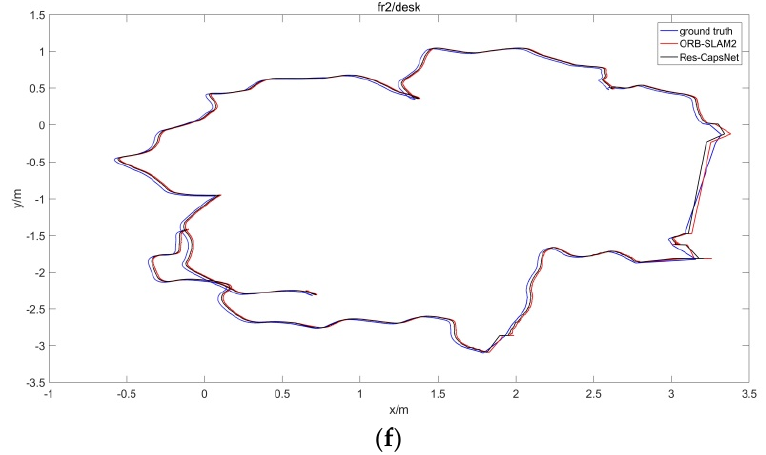
Figure 15. Absolute trajectory error comparison for SLAM. ( a ) fr3/sitting-xyz, ( b ) fr3/sitting-halfsphere, ( c ) fr3/walking-xyz, ( d ) fr3/walking-halfsphere, ( e ) fr3/long-office, ( f ) fr2/desk.